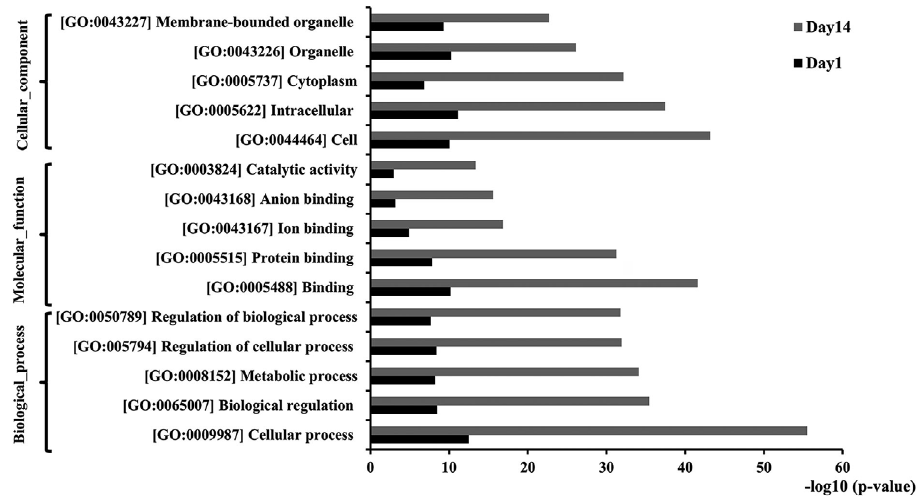
Figure 3- The top 5 most enriched GO terms for each subgroup based on the level of significance, which consisted of cellular component, molecular function and biological